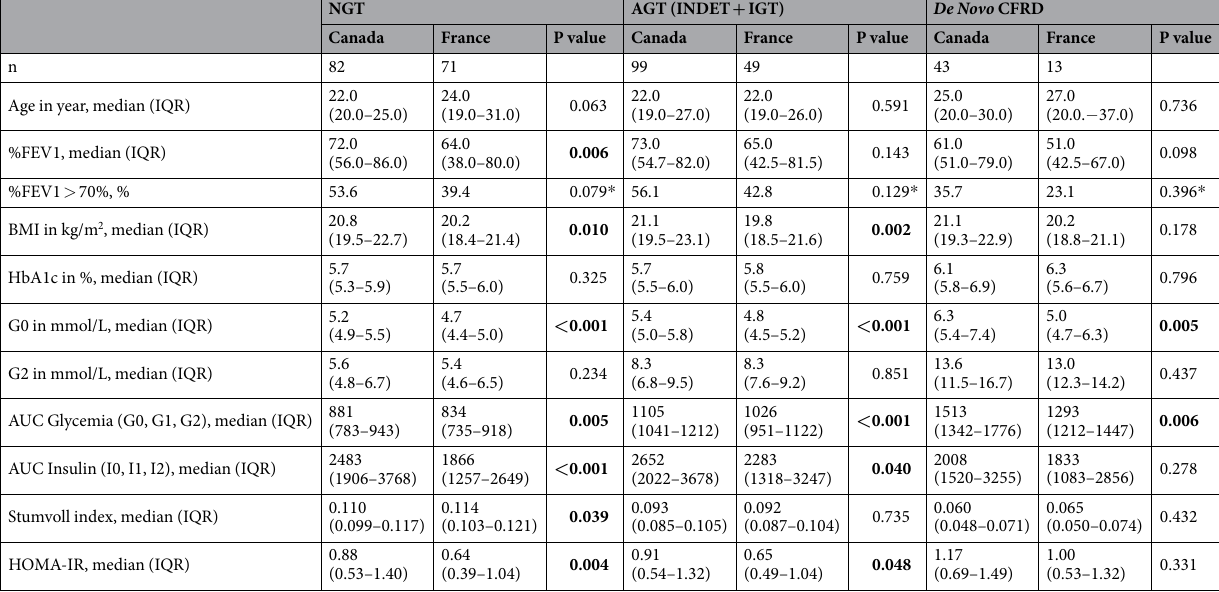
Table 2. Comparison between glucose tolerance groups of the Canadian and French patients. Bold values represent significant differences. Abbreviations: AGT: Abnormal glucose tolerance (INDET: indeterminate glucose tolerance + IGT: impaired glucose tolerance), AUC: area under the curve, BMI: body mass index, CFRD: cystic fibrosis-related diabetes, CRP: C reactive protein,FEV1: predicted forced expiratory volume in 1 second, HbA1c: glycated hemoglobin, HOMA-IR: Homeostasis model assessment of insulin resistance, NGT: normal glucose tolerance. Mann-Whitney analysis were performed except for p value with * that were determined by chi 2 .